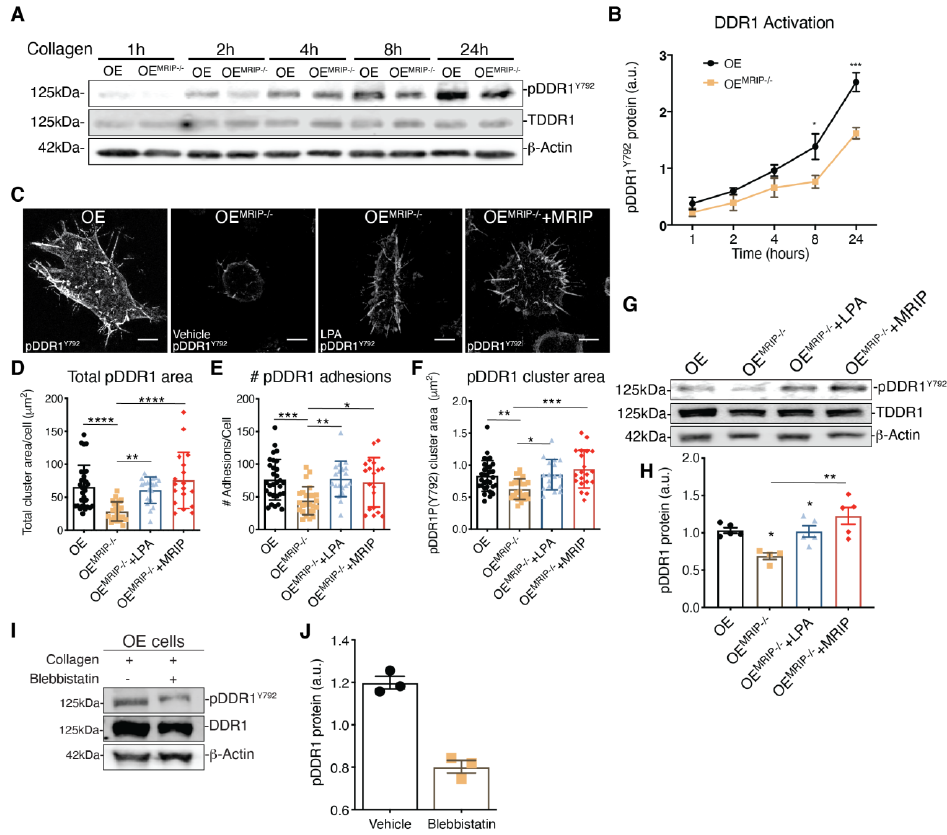
Figure 5. MRIP stabilizes DDR1 activation. ( A ) Cells were cultured on fibrillar collagen-coated tissue culture dishes for indicated times; whole cell lysates were immunoblotted for pDDR1 Y792 (#11994, CS), DDR1 (C-6: sc-374618), and β -Actin. ( B ) Quantification of pDDR1 Y792 / DDR1 by densitometry of immunoblots, n = 3. ( C ) Cells were cultured on fibrillar collagen films for 8 h; an antibody